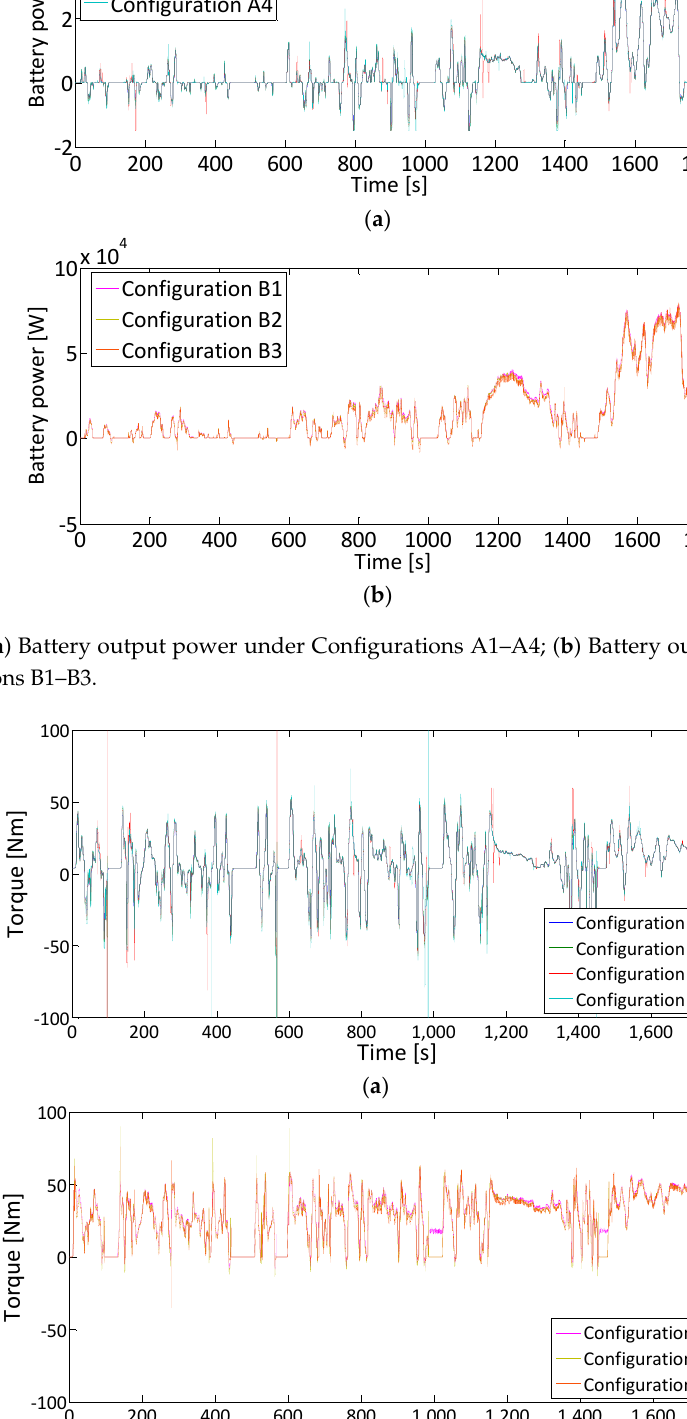
Figure 13. ( a ) Electric motor torque under Configurations A1–A4; ( b ) Electric motor torque under Configurations B1–B3.